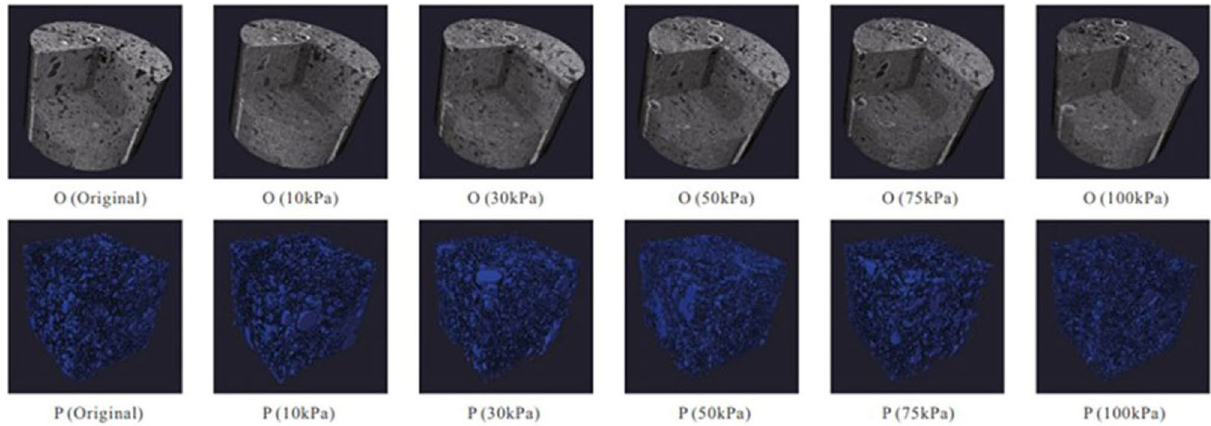
Figure 4. Changes of rock skeleton and pore structure with confining pressure 22